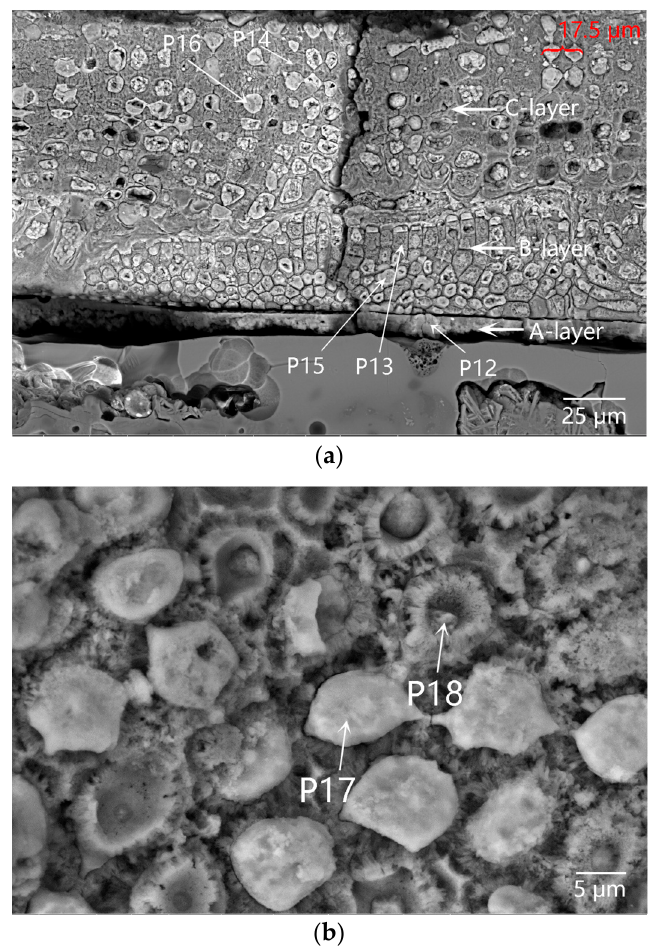
Figure 10. SEM images of the cellular-structure coagula attached to the outer surface of sample DL-1: ( a ) coagula (A-layer), coralline algae skeleton and filler (B-layer and C-layer) in the No. 2 box of Figure 8a, observed upon the cross-section; and ( b ) coralline algae skeleton and filler observed upon the surface.